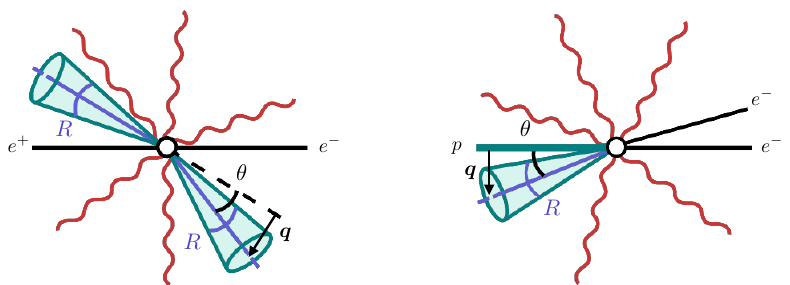
Figure 1 . Geometry of the event for e + e (cid:0) ! dijet (left) and SIDIS (right). The horizontal direction represents the beam axis. For dijets the relevant quantities q and (cid:18) are the transverse momentum decorrelation and angular decorrelation of the system, de(cid:12)ned with respect to the relative orientation of the two jets. We consider almost back-to-back jets, (cid:18) 1, and study di(cid:11)erent (cid:28) hierarchies between (cid:18) and the jet radius R . In SIDIS q represents the transverse mometum of the jet, and the corresponding angle is measured with respect to the beam axis. We work in the